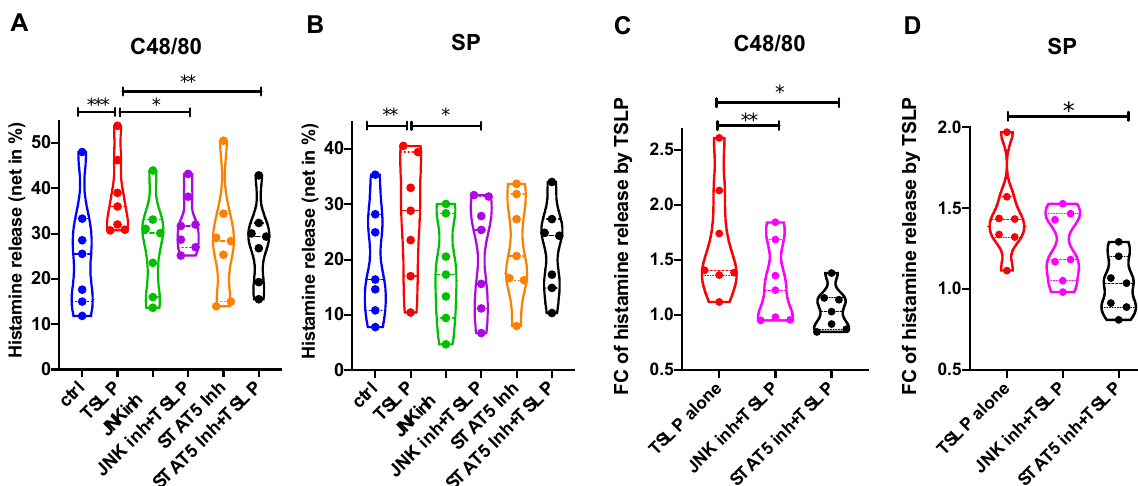
Figure 5. TSLP support of MRGPRX2-triggered degranulation depends on STAT5 and JNK. MCs were pretreated with the JNK inhibitor SP600125 (5 µM), the STAT5 inhibitor Pimozide (5 µM) or no inhibitor (buffer control) for 15 min, then stimulated with TSLP (7.5 ng/mL) for 30 min. ( A , B ) Histamine release was assessed after further 30 min with c48/80 (10 µg/mL) or SP (30 µM), and the net release calculated. ( C , D ) Fold change (FC) of histamine release in the presence of TSLP, calculated as ratio (with TSLP)/(without TSLP). The data are from 7 independent experiments. * p < 0.05, ** p < 0.01, *** p < 0.001. In A and B, the relevant comparisons (groups: control, JNK inhibitor + TSLP, STAT5 inhibitor + TSLP) were made against the “TSLP” group (red violin); in C and D , inhibitor groups were compared with “TSLP alone” (red violin). Cells 2021 , 10 , x